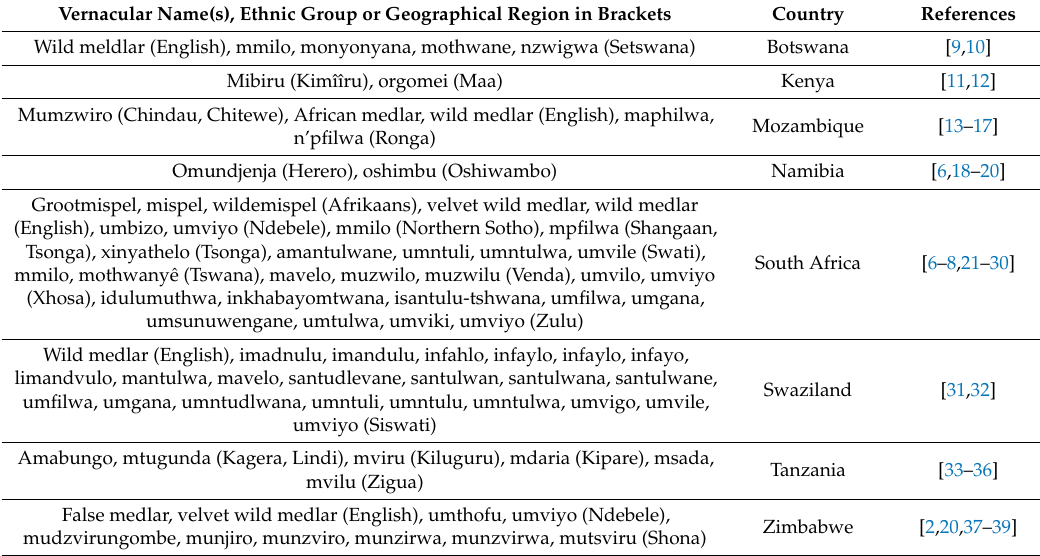
Figure 1. Distribution of Vangueria infausta subsp. infausta in the mainland tropical Africa. Table 1. Vernacular names of Vangueria infausta subsp. infausta in the mainland tropical Africa. Vernacular Name(s), Ethnic Group or Geographical Region in Brackets